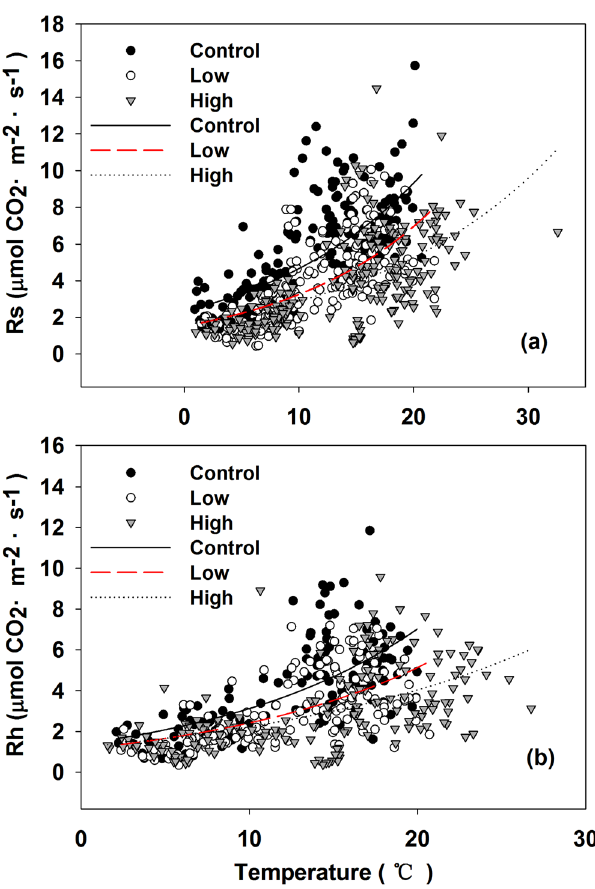
Figure 3. Seasonal variation of total soil respiration rates ( R s) ( a ), heterotrophic respiration rates ( R h) ( b ) against soil respiration at a 5 cm depth for the control, low, and high burning severity